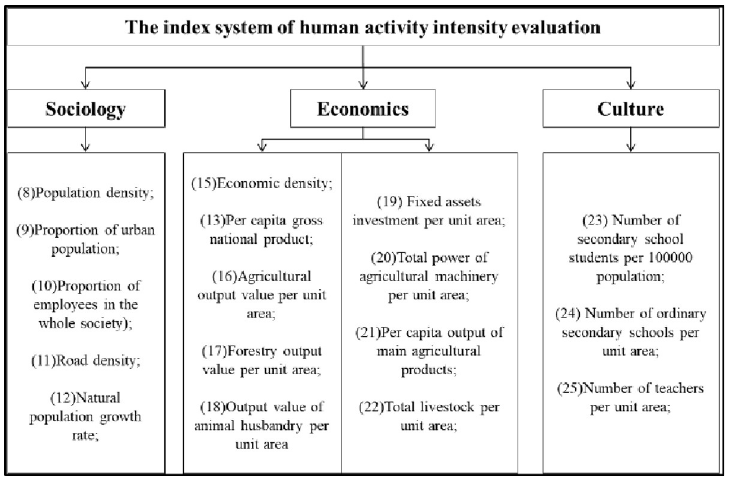
Fig 3. Quantitative index system of regional human activity intensity.